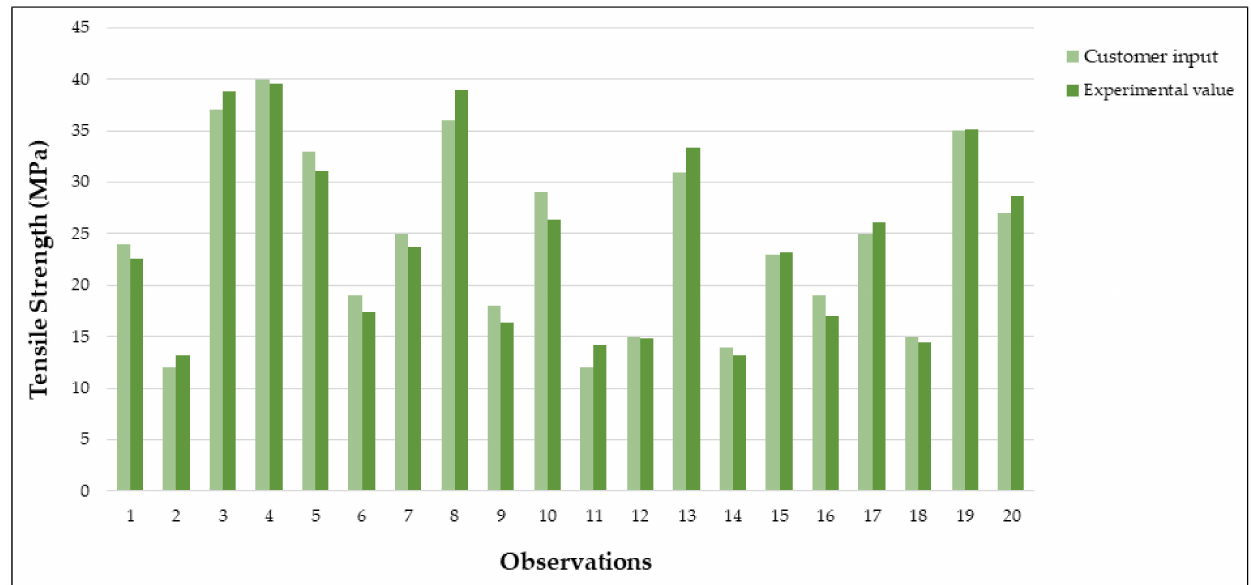
Figure 22. Customer desired and experimental tensile data for model